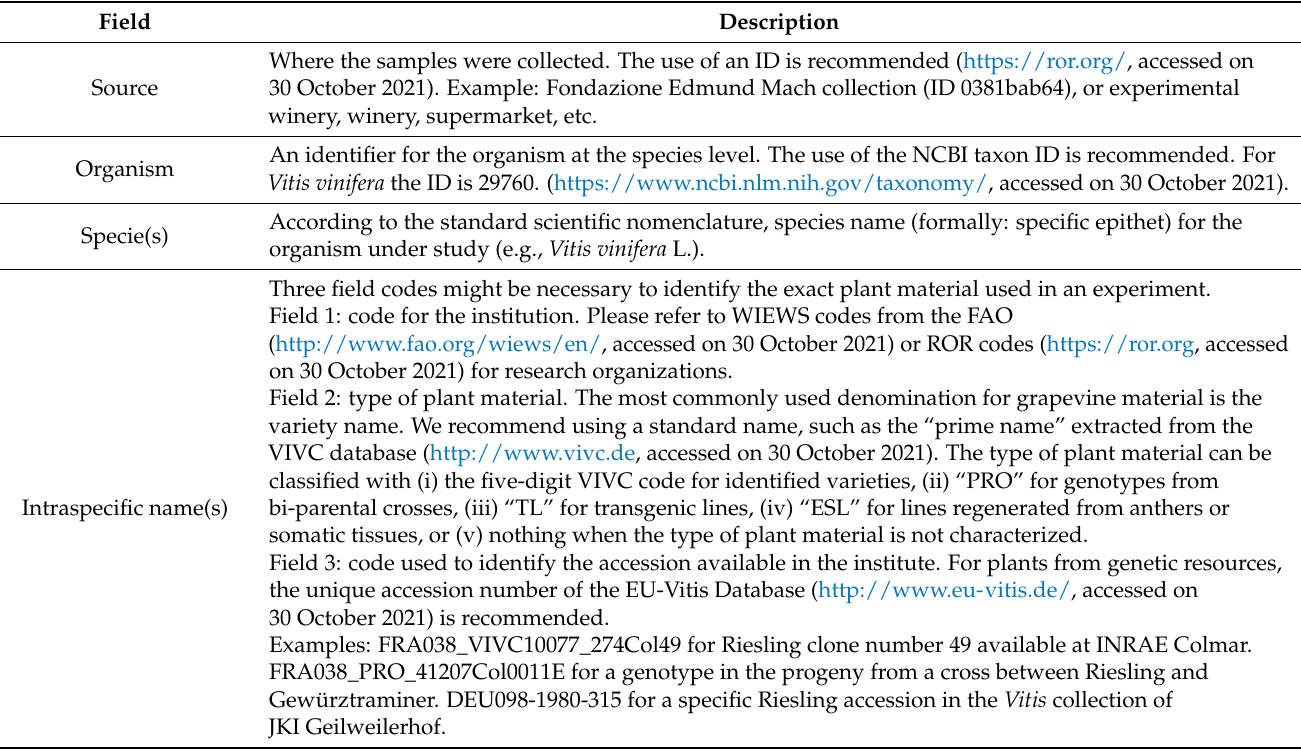
Figure 1. Overview of the required data and metadata management steps supplied with basic information on grapevine phenotyping and chromatography mass spectrometry techniques. Detailed information is included in each table. Table 1. Sampling protocol (plant materials or wine